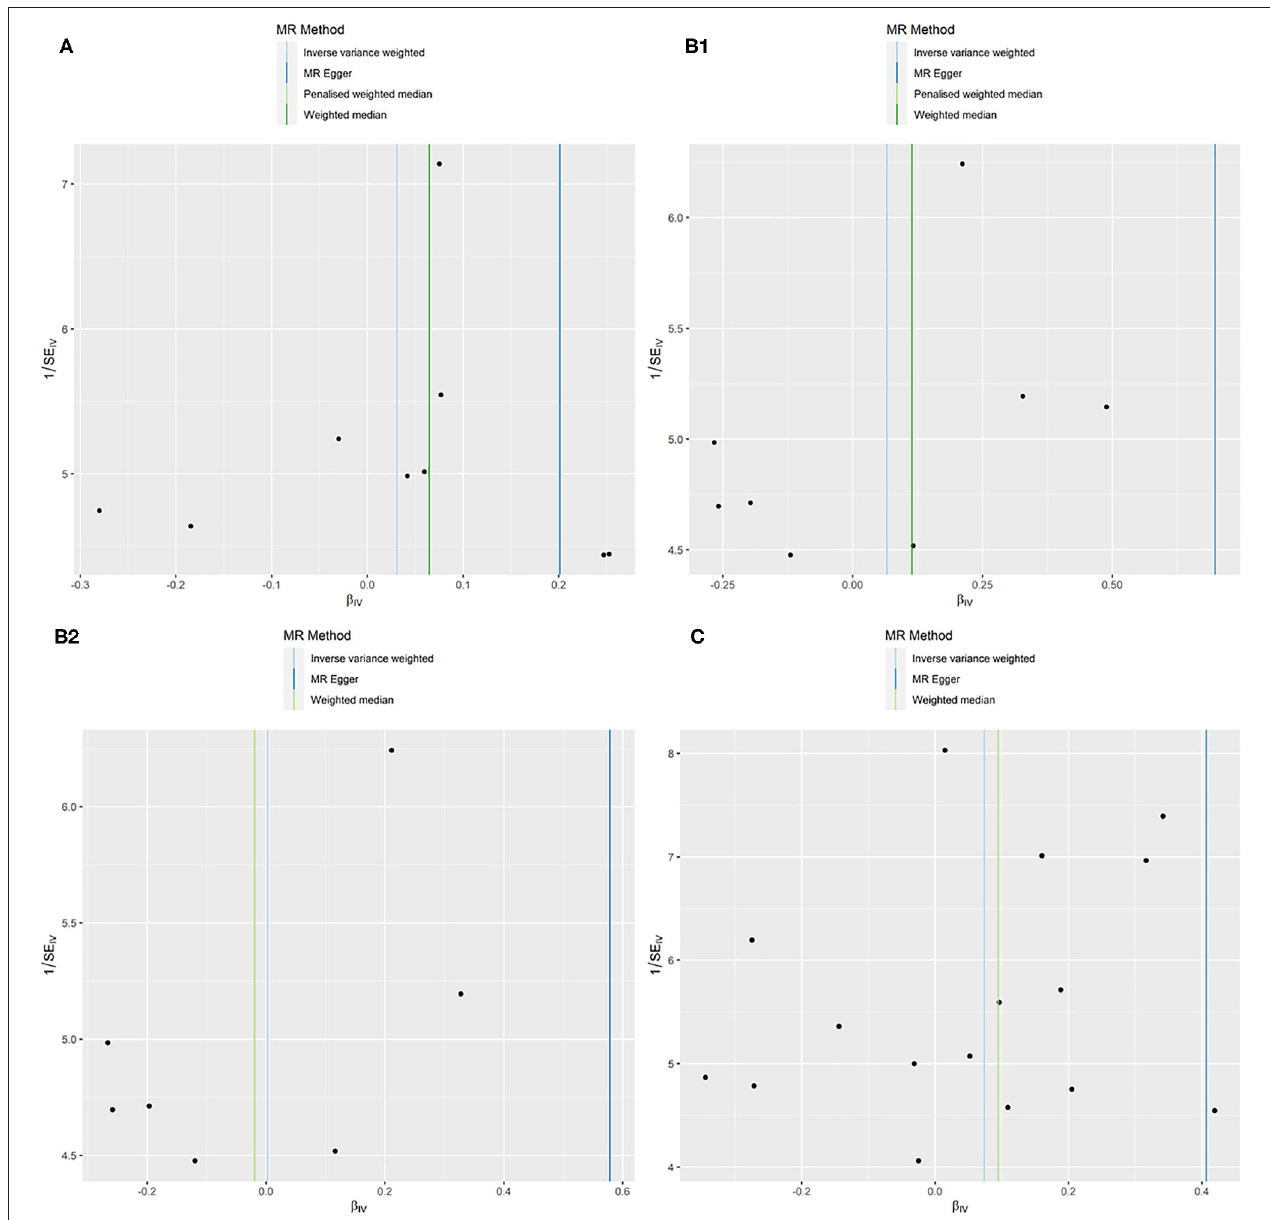
FIGURE 3 | MR funnel plots: FEV1 for AF (A) ; FVC for AF (B1) : not removing the outlier SNP; (B2) : removing the outlier SNP; FEV1/FVC for AF (C) .